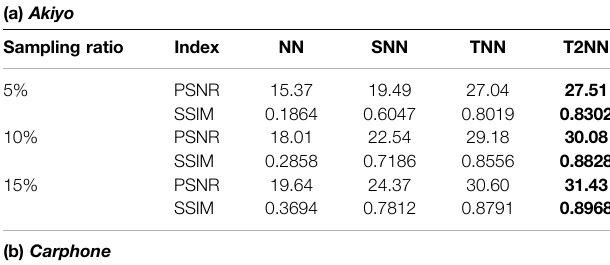
TABLE 1 | PSNR and SSIM values obtained by four norms (NN [30], SNN [22], TNN [25], and our T2NN) for noisy tensor completion on the YUV